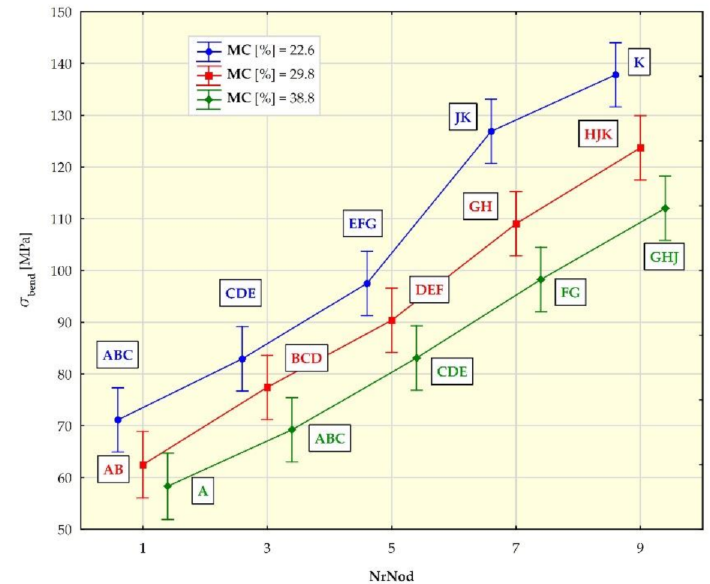
Figure 10. Average maximum stress in bending ( σ bend ) values for different internodes (NrNod) and moisture content (MC). All data are expressed as mean ± 95% confidence interval (the latter being represented by whiskers in the diagram). Different letters indicate significant differences between the groups according to Tukey’s test ( p < 0.05). Homogeneous groups are marked with the same letters. Individual homogeneous groups, determined on the basis of the HSD Tukey test, to which individual averages belong, are marked with capital letters. For example, for MOEcompr (Figure 7), the homogeneous group A consists of means for NrNod = 1 and MC = 20.7% as well as NrNod = 1 and MC = 25.8%. Homogeneous group B consists of means for NrNod = 1 and MC = 25.8% as well as NrNod = 3 and MC =